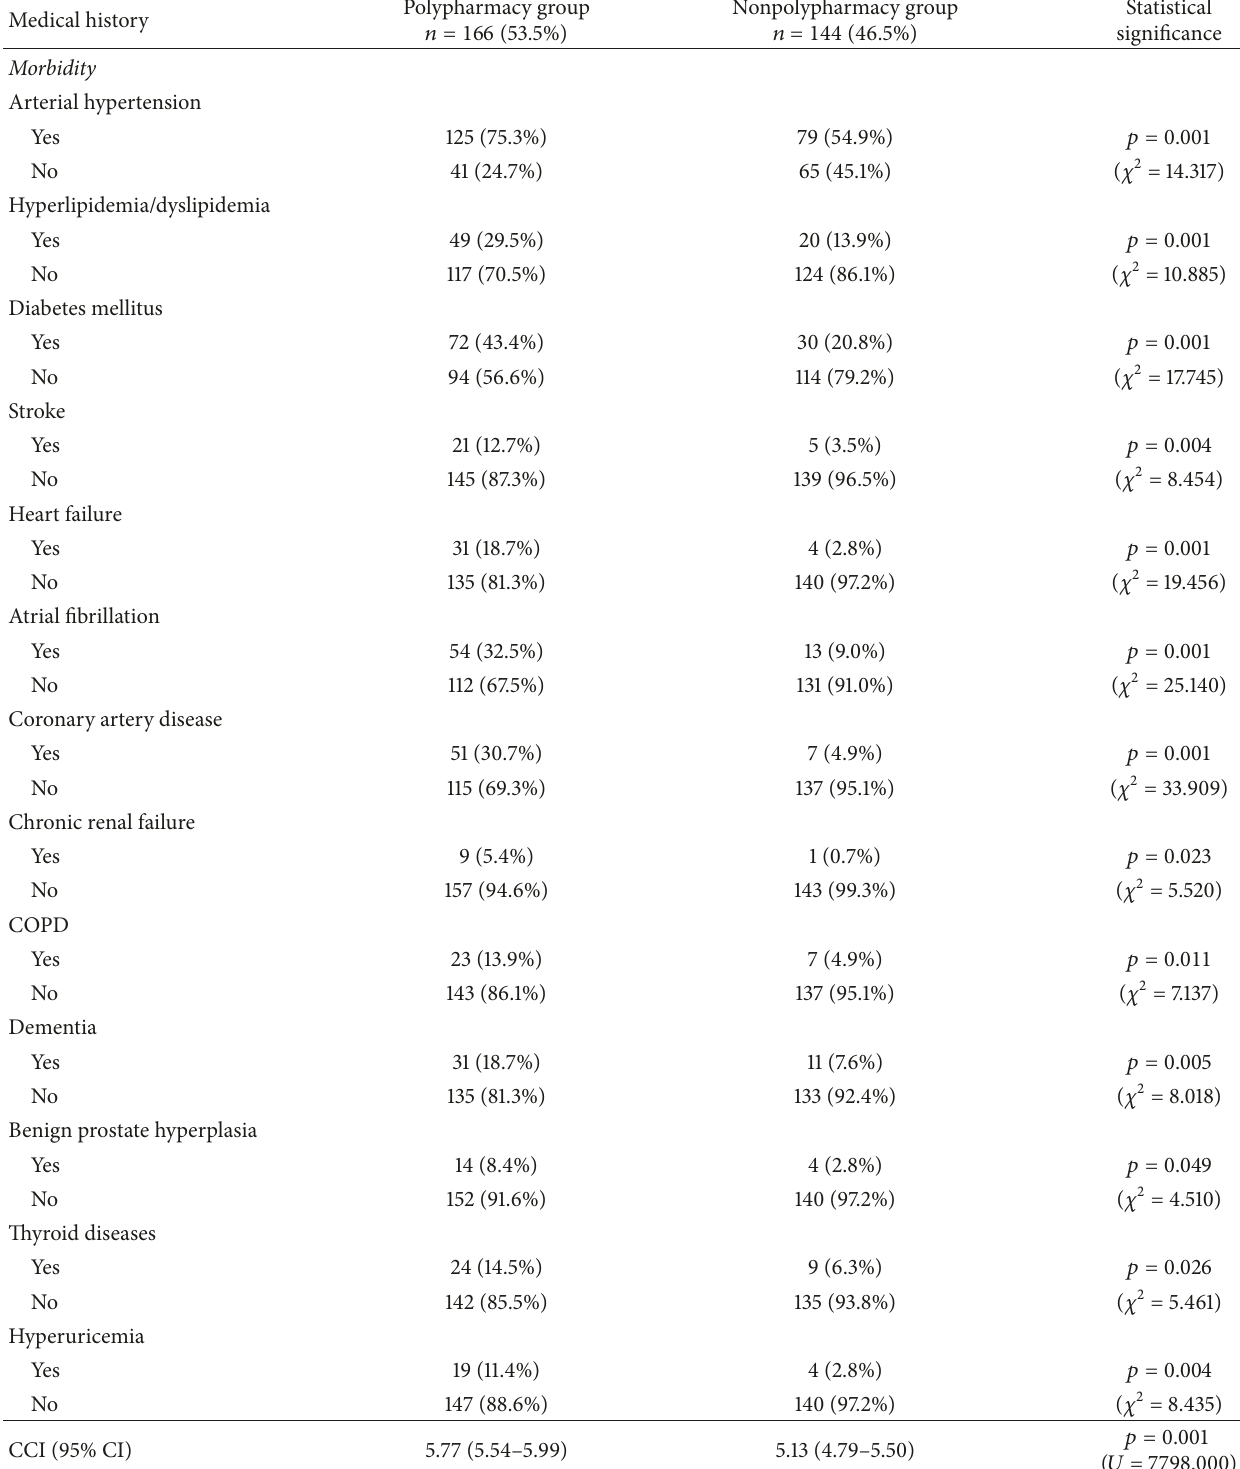
Table 2: Comparison of medical history between patients in polypharmacy and nonpolypharmacy group. Medical